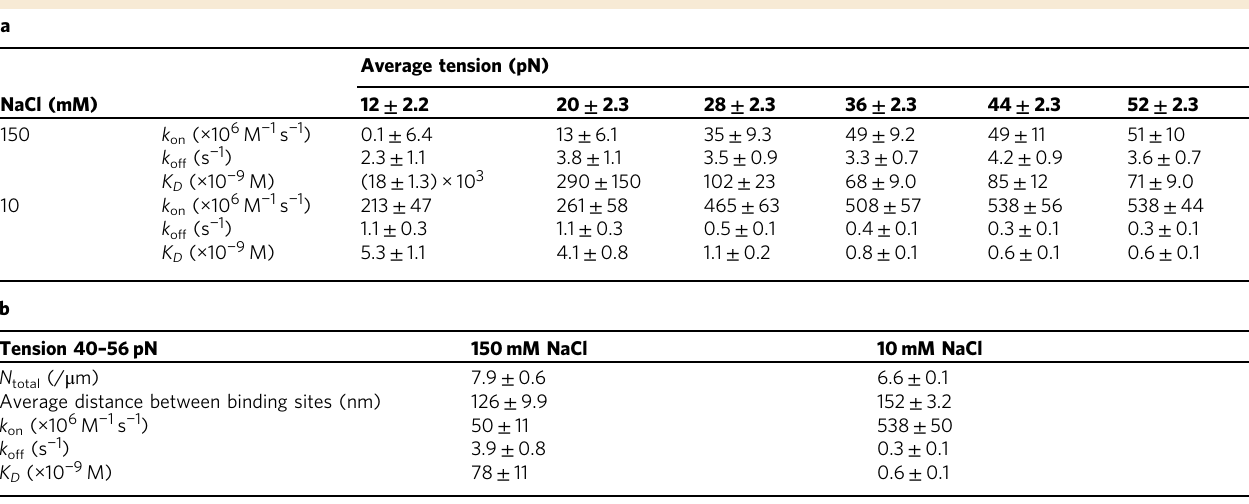
Average tension (pN)